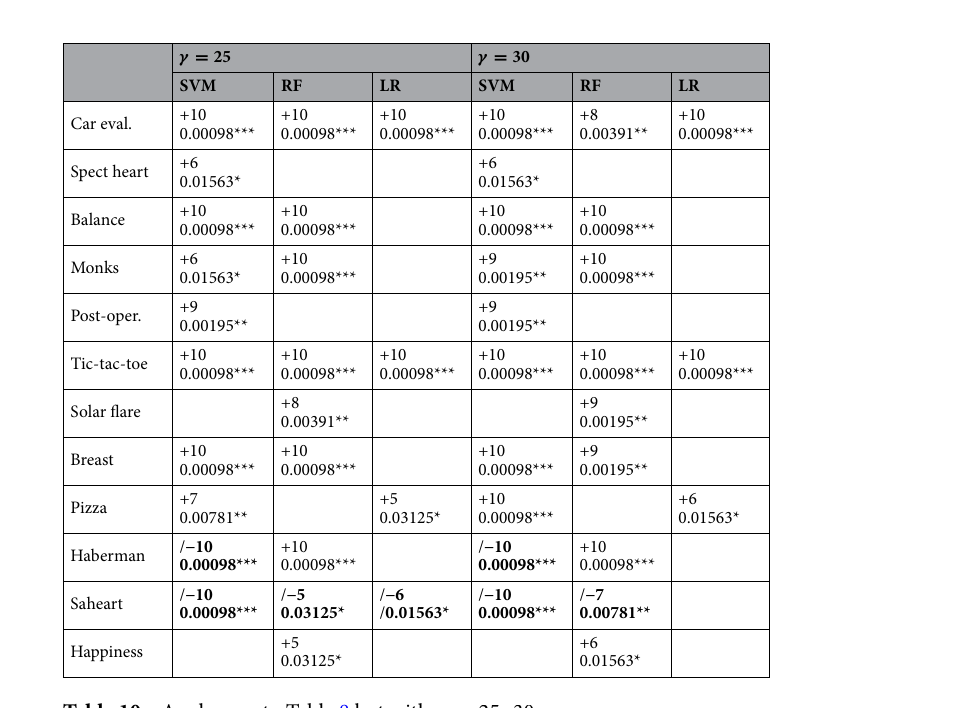
Table 10. Analogous to Table 8 but with γ = 25, 30